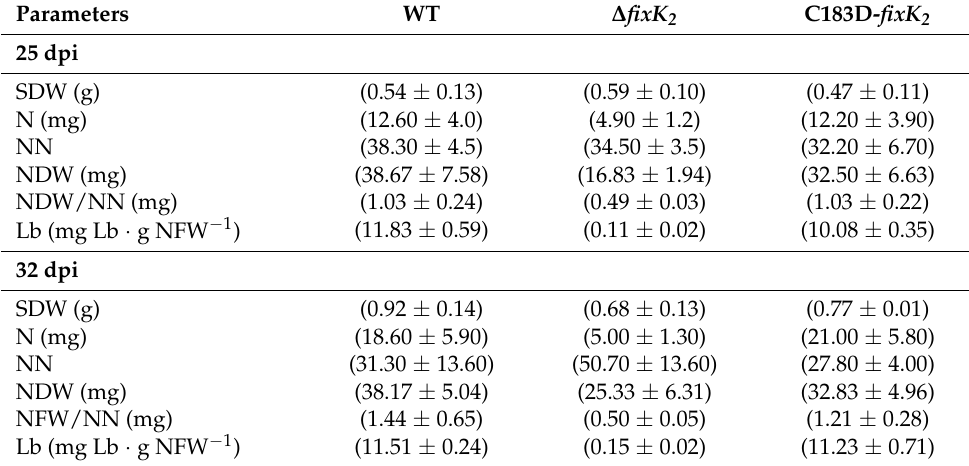
Table 1. Symbiotic phenotype of different B. diazoefficiens strains on soybean plants. Shoot dry weight (SDW), nitrogen shoot content (N), nodule number per plant (NN), nodule dry weight per plant (NDW), dry weight per nodule (NDW/NN) and leghemoglobin content in nodules (Lb) were determined at 25 and at 32 days post-inoculation (dpi). WT, wild type.